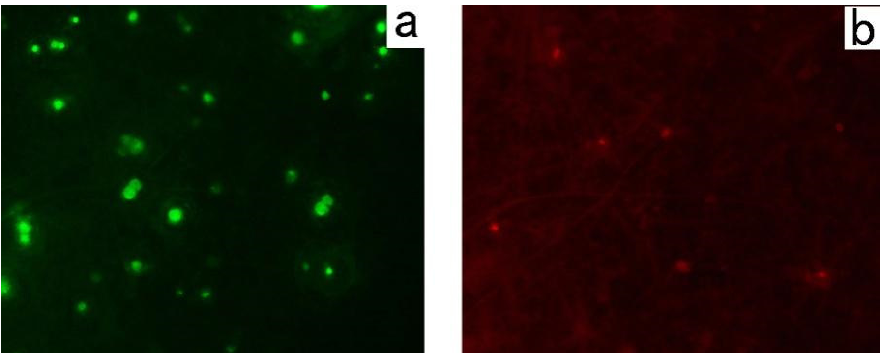
Figure 8. Human fibroblasts L929 supportive properties of D-Azo-D 230 hydrogels. After hydrogel swelling in culture medium for 24 h, L929 were seeded onto the hydrogels surface and incubated for 24 h: ( a ) live cells on the hydrogel; ( b ) dead cells on the hydrogel.